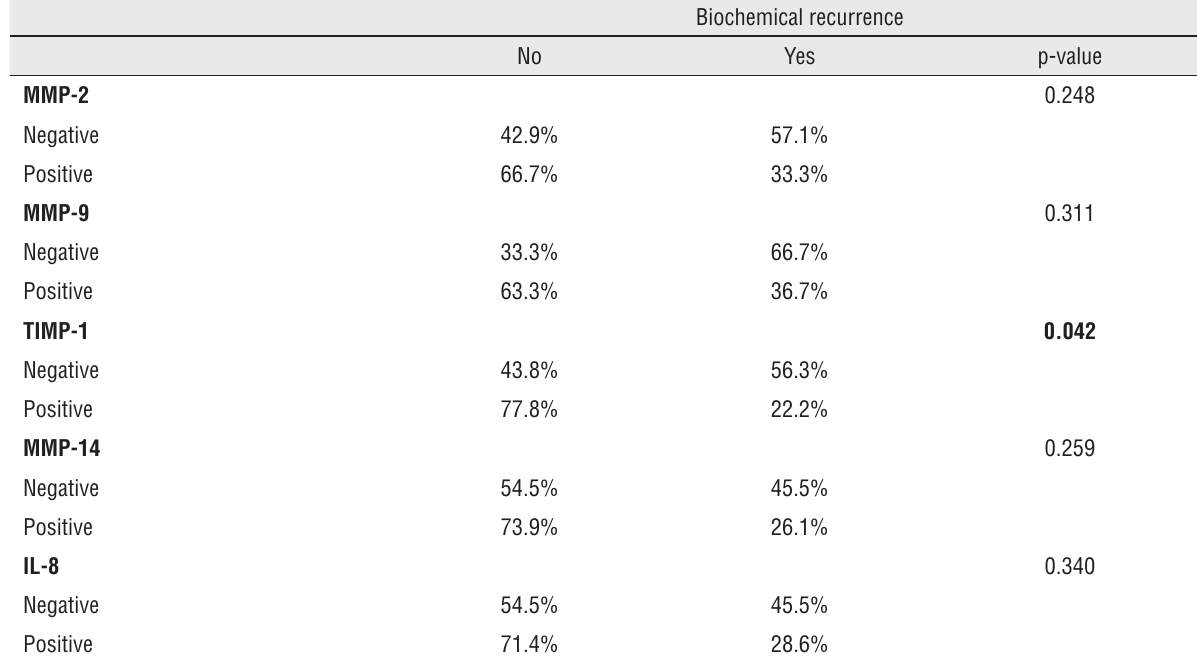
Table 4 - protein expression accordding to biochemical